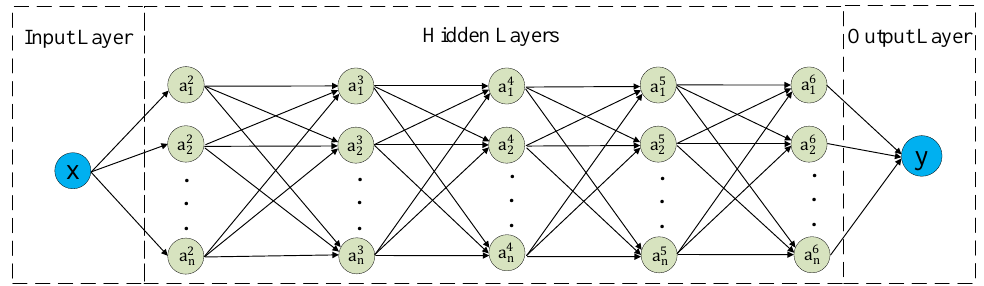
Figure 12. Architecture of the feed-forward neural network used to predict guidewire force. The ANN has an input, an output, and five hidden layers.